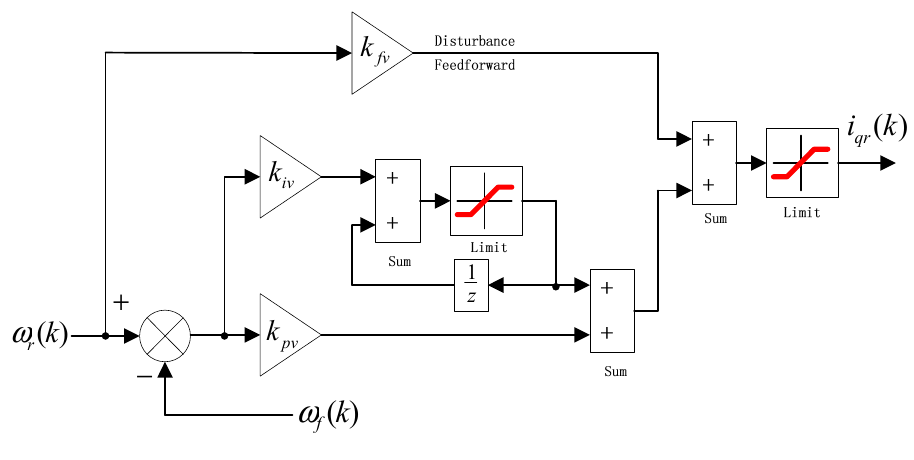
Figure 3. The structure of PIF